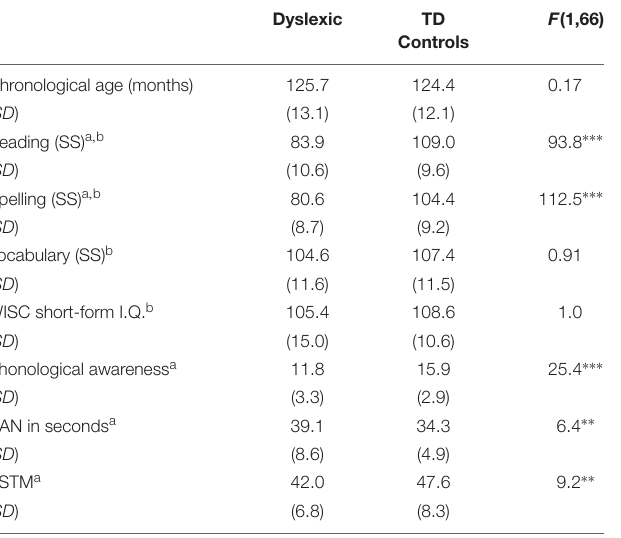
TABLE 1 | Participant details for Experiment 1.